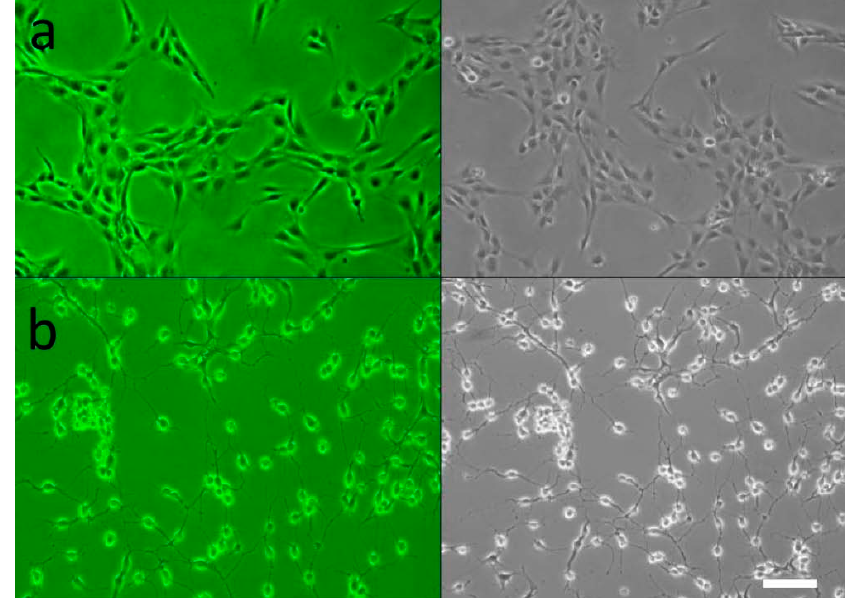
Figure 6. Human airway epithelial cells in the presence of alternariol (AOH). BEAS-2B cells were incubated with 10 μ M of AOH for 24 h under normal conditions at 37 °C, 5% CO 2 . The images were taken with confocal microscopy with a cell density of 5 × 10 5 cells/well (magnification 200×). ( a ) Untreated BEAS-2B cells at 24 h in color (upper left panel) and grey-scale (upper right panel); ( b ) BEAS-2B with 10 μ M AOH at 24 h in color (lower left panel) and grey-scale (lower right panel). Scale bar = 100 μ m.